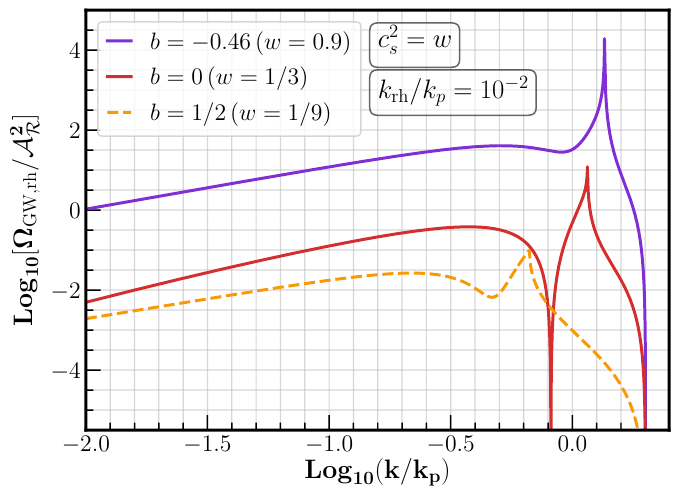
Figure 3. Induced GW spectral density for a Dirac delta primordial spectrum, in terms of wavenum- ber k / k p . We restricted the plot to k > k rh . We show the induced GW generated in a radiation dominated universe (red line), in a stiff fluid domination with w 0.9 (purple line) and in a soft ∼ fluid domination with w = 1/9 (orange line). All cases have c 2 s = w and, thus, the spectrum presents the resonant peak at k 2 c 2 s k p . We see that for softer w , the position of the peak moves to the left. We ∼ also see that stiff w enhances the overall amplitude of the induced GW spectrum and has a sharper resonant